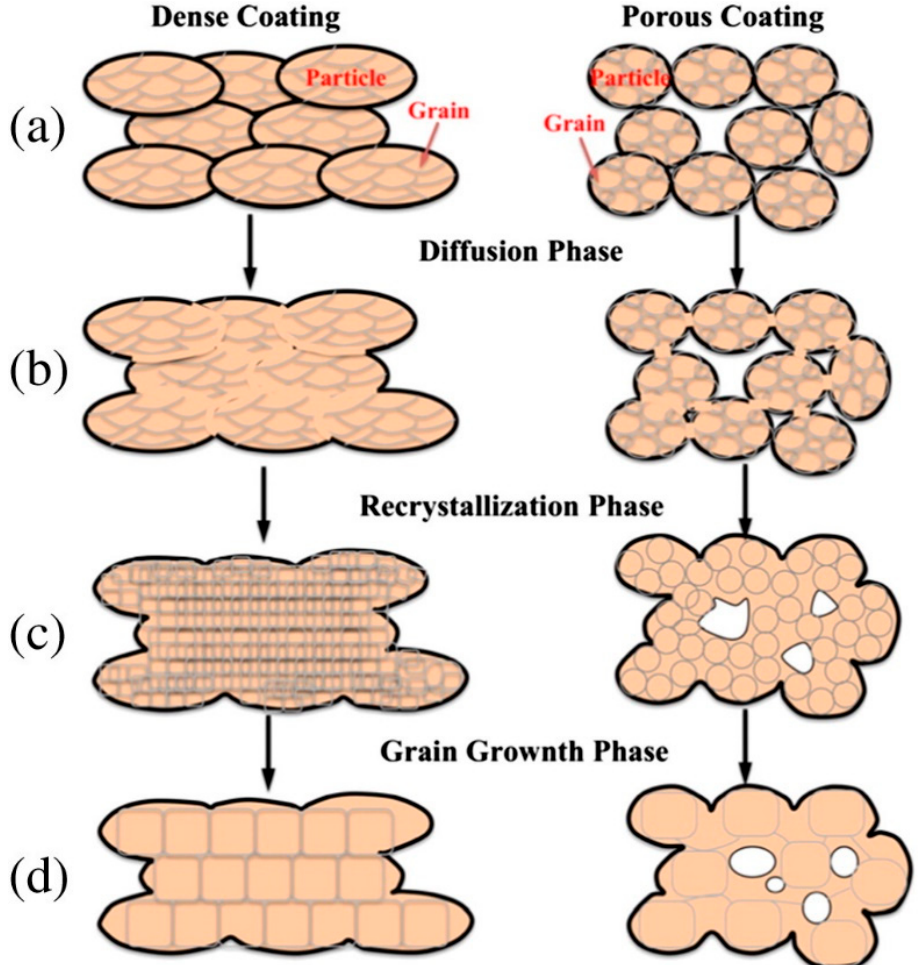
Figure 1. Microstructure evolution of cold sprayed dense and porous deposits during post HT (adapted from reference [28] , with permission from © Elsevier).